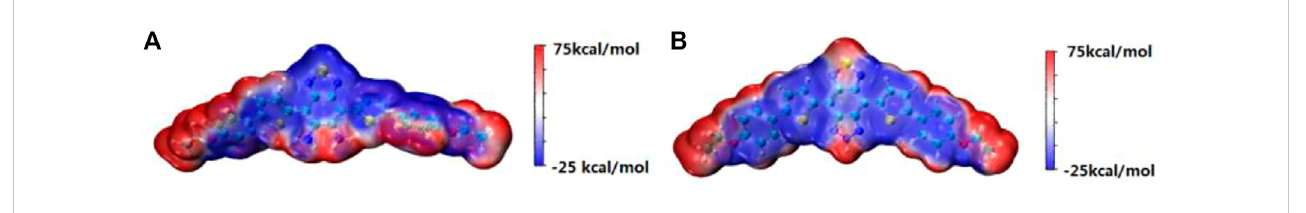
Electrostatic potential of (A) DAD-NO and (B)